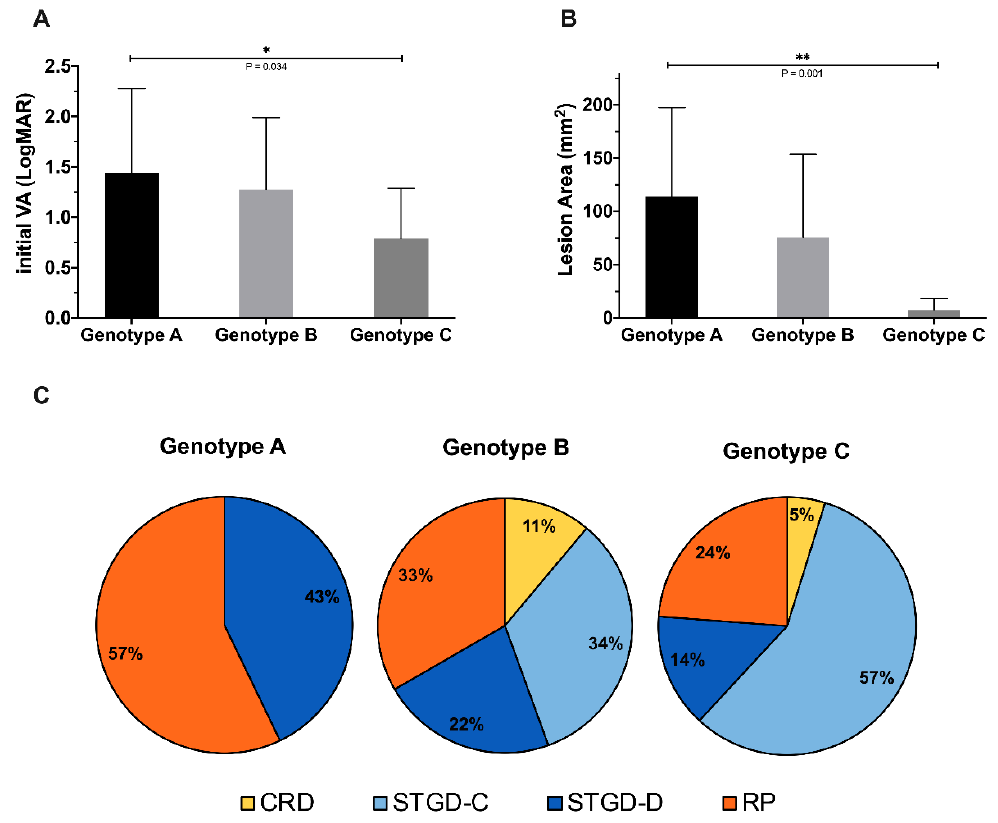
Figure 9. Genotype–phenotype correlations. ( A ) Three genotype groups with corresponding visual acuity at the first visit. ( B ) Three genotype groups with corresponding lesion areas in the first fundus autofluorescence imaging of each patient. ( C ) Distribution of the clinical phenotypes of each genotype group.